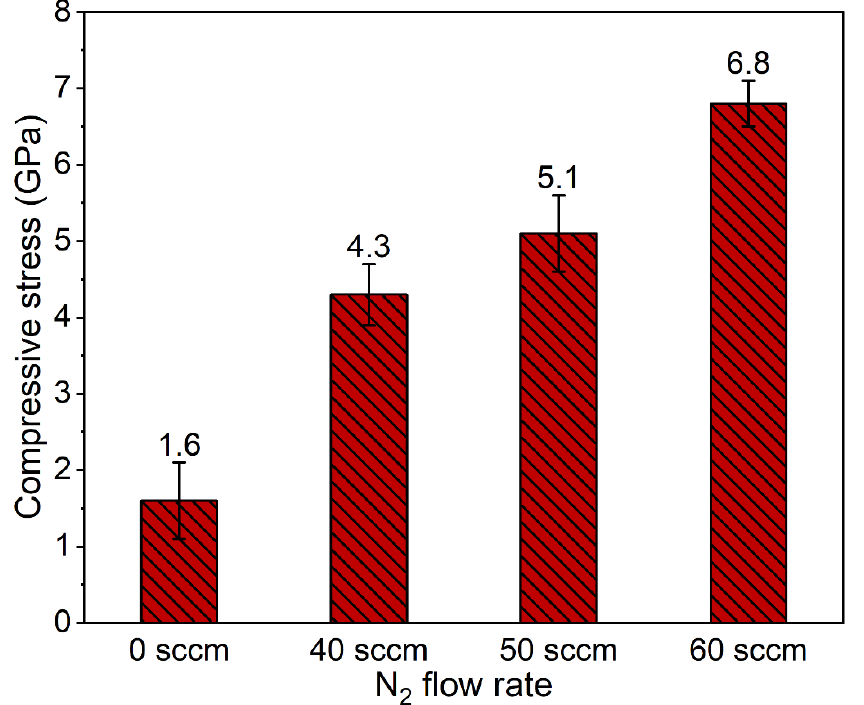
Figure 10. Residual stress of the different samples deposited using different nitrogen flow rates.